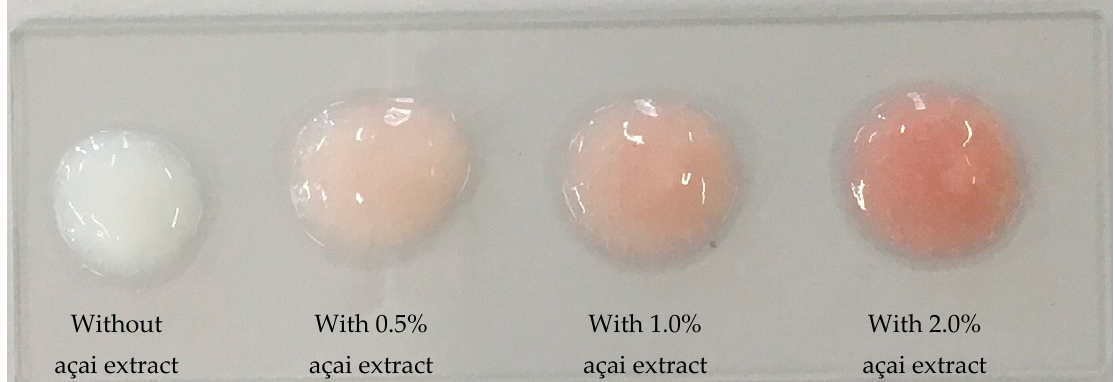
Figure 1. Colours of the emulsions according the presence of the açai extract.